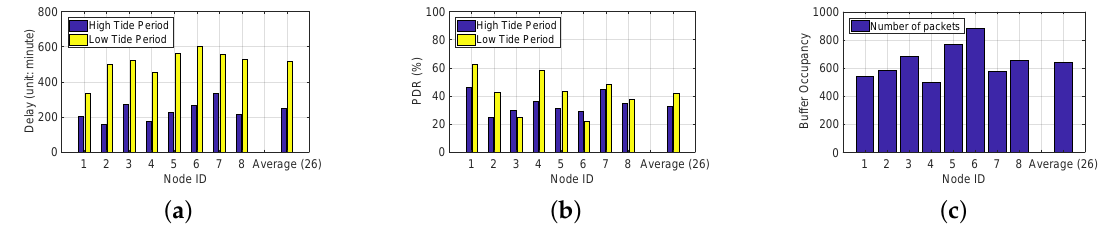
Figure 2. The delay, PDR and buffer condition in an IT-WSN in Zhoushan, China. We evaluate the average delay and PDR of all 26 nodes (“Average (26)”) in the Zhoushan system, and we select eight nodes (Node 1–Node 8) as representatives. ( a ) The average delay of 8 nodes and the average delay of all nodes in Zhoushan experiment during high tide period and low tide period; ( b ) The average PDR of 8 nodes and the average PDR of all nodes in Zhoushan experiment during high tide period and low tide period; ( c ) The average buffer occupancy of 8 nodes and the average buffer occupancy of all nodes in Zhoushan